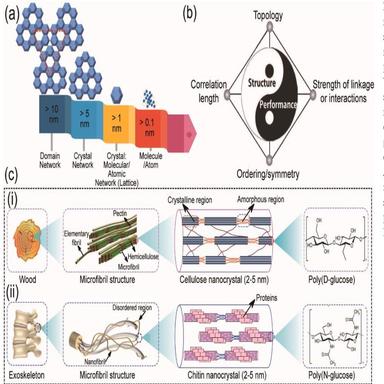
(a) Multilevel structures of crystal networks. (b) Scheme illustrating the four structural factors determining the performance of soft materials. Reproduced with permission . Copyright 2016, Wiley-VCH. (c) Hierarchical structure and crystal structures are identified in many natural materials such as wood and arthropod exoskeleton. Wood consists of a line chain of β-(1,4)-linked D-glucose units, and exoskeleton is made of a line chain of β-(1,4)-linked N-glucose units. The nanocrystal size of th